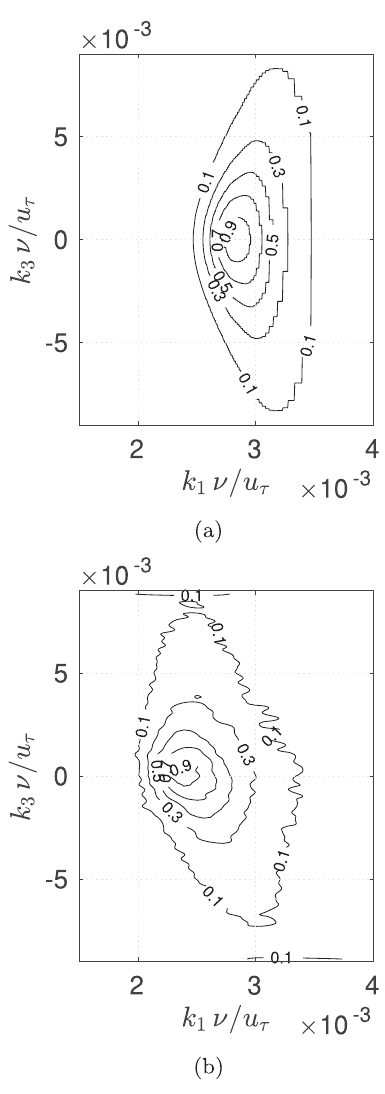
Figure 12. Contour levels of the spectra ’ s convective ridge for (a) modelled and (b) experimental data at x + = 0.05, Re + = 1.8 (cid:3) 10 3 and b P = (cid:2)